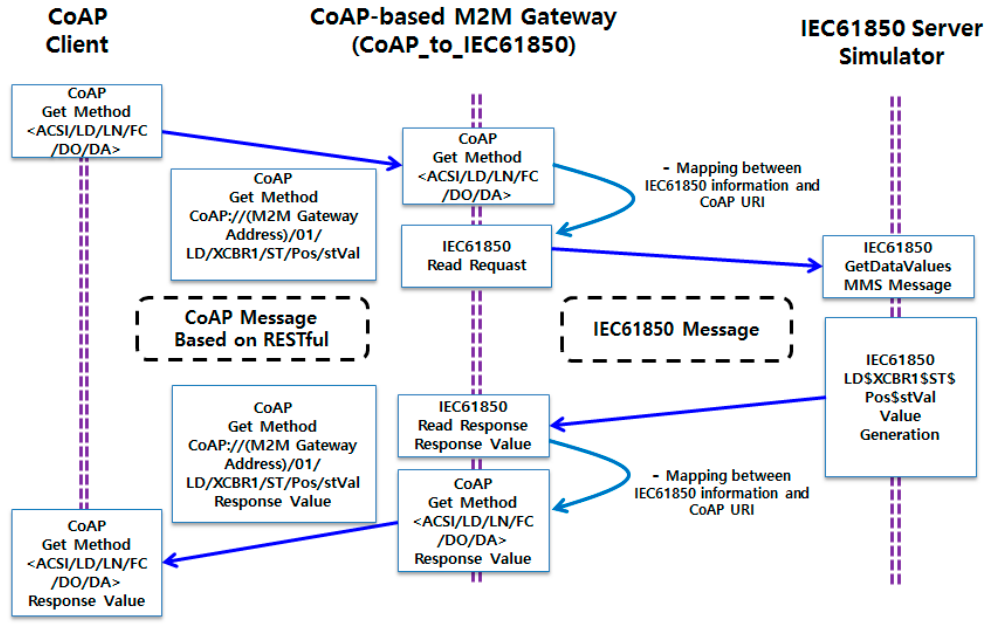
Figure 8. Sample message sequence chart between the IEC 61850 and CoAP.